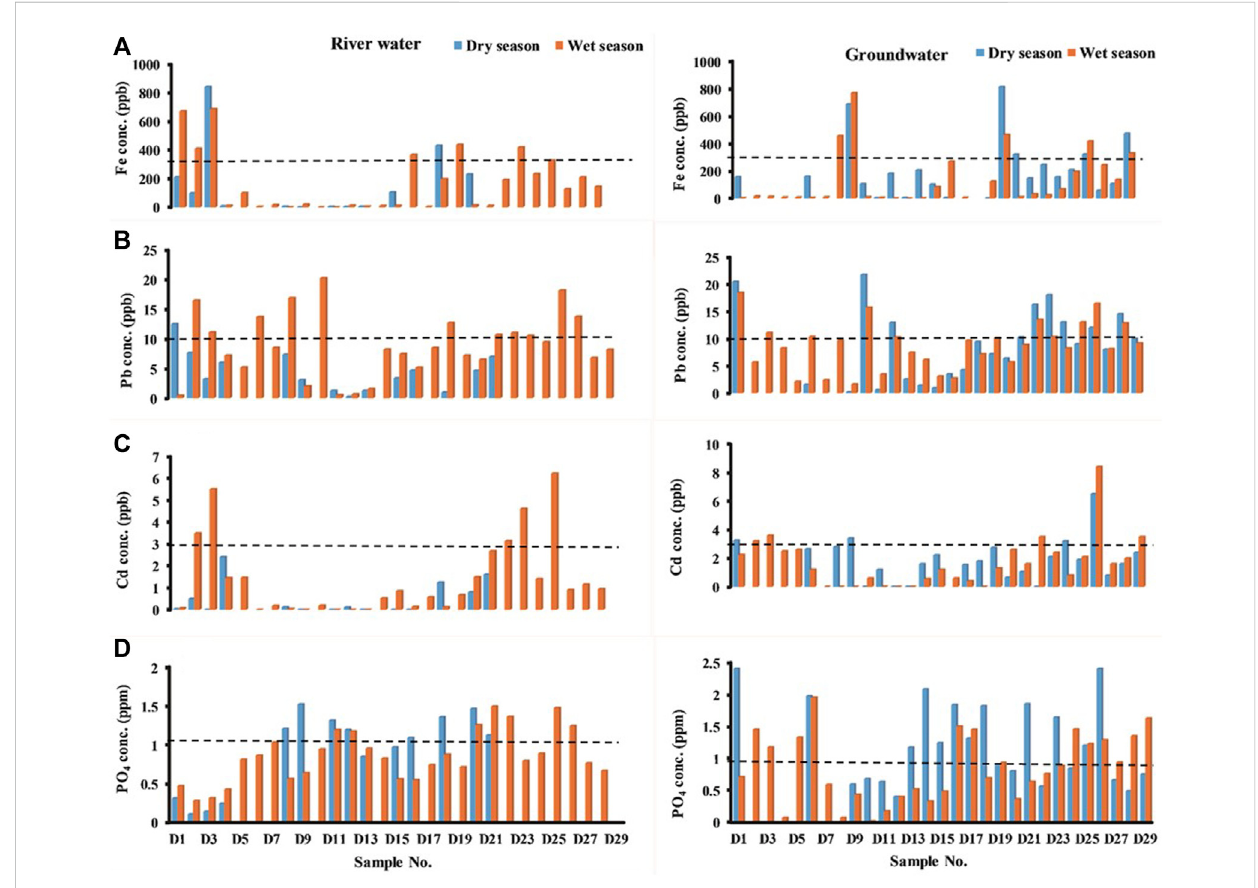
FIGURE 3 Trace elements measured in river water and groundwater: (A) Fe, (B) Pb, (C) Cd, and (D) PO 4